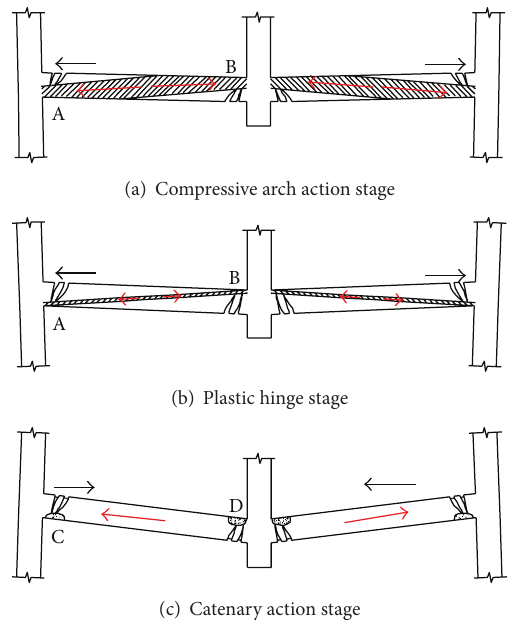
Figure 20: Load transfer mechanisms of frame with specially shaped